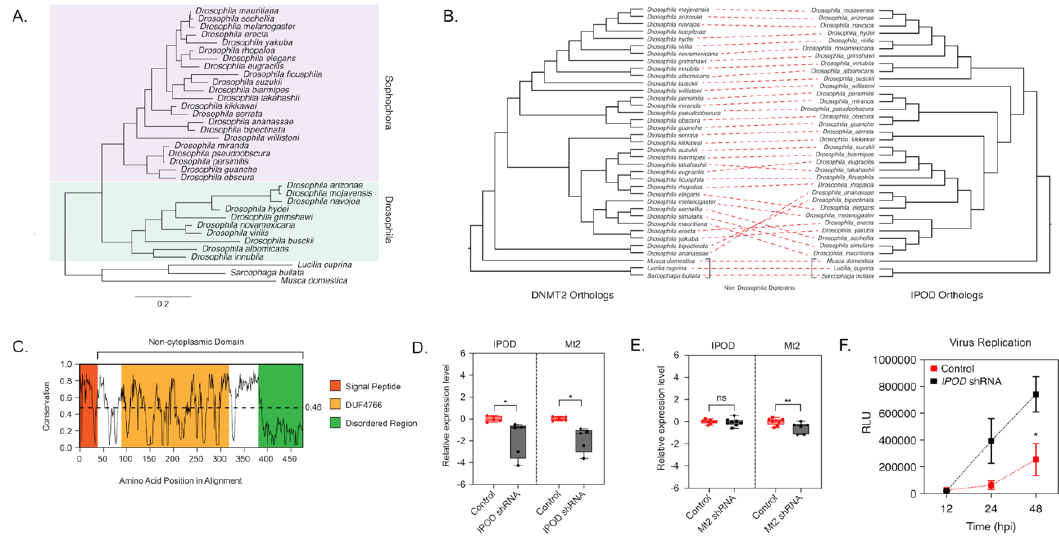
Figure 2. IPOD regulates DNMT2 expression in Drosophila. ( A ) maximum-likelihood [43] tree of the interaction partner of DNMT2 ( IPOD ) gene present in multiple Drosophila species was constructed using RAxML using a multiple sequence alignment of IPOD nucleotide sequences. The sequence of the IPOD orthologs from Lucilia cuprina, Musca domestica, and Sarcophaga bullata were used as outgroups. Scale bars represent branch lengths. ( B ) Inter-protein co-evolutionary analyses of DNMT2 and IPOD orthologs were performed using the TreeCmp software packages. Red dashed lines connect the same Drosophila taxon. ( C ) Shannon conservation plot representing the degree of conservation ( Y -axis) of IPOD orthologs present at every amino acid position ( X -axis) across Drosophilids . The horizontal dashed line indicates the mean conservation score (0.46) across all amino acid positions. Colored boxes represent three InterPro domains identified across all IPOD orthologs in Drosophilids , including the N-terminal signal peptide (depicted in orange), followed by a C-terminal non-cytoplasmic domain (depicted in white) consisting of a conserved domain of unknown function (DUF4766, depicted in yellow) and a glycine-rich disordered region (depicted in green) present at the C-terminal end. ( D , E ) IPOD is an upstream regulator of Mt2 expression in Drosophila melanogaster . ( D ) IPOD expression was knocked down in Wolbachia w Mel-colonized Drosophila melanogaster (TRiP line# 60092) by driving expression of a targeting short-hairpin RNA (shRNA) against the target IPOD mRNA. Relative expression of the target IPOD mRNA and Mt2 mRNA was assessed via quantitative RT-PCR using total RNA derived from age-matched females. Siblings lacking the shRNA were used as the negative control. Two-tailed t -tests on log-transformed values; IPOD : p < 0.05, t = 3.678, df = 8.00, Mt2 : p < 0.05, t = 2.454, df = 8.00. Error bars represent the standard error of the mean (SEM) of experimental replicates ( n = 5). ( E ) Mt2 expression was knocked down in Wolbachia w Mel-colonized Drosophila melanogaster by driving expression of a targeting short-hairpin RNA (shRNA) against the target mRNA. Relative expression of the target Mt2 mRNA and IPOD mRNA was assessed via quantitative RT-PCR using total RNA derived from age-matched females. Siblings lacking the shRNA were used as the negative control. Two-tailed t -tests on log-transformed values; Mt2 : p < 0.01, t = 2.576, df = 12.00, IPOD : p = 0.717969, t = 0.3686, df = 14.00. Error bars represent the standard error of the mean (SEM) of experimental replicates ( n = 6–8). ( F ) Effect of IPOD knockdown on Wolbachia- mediated virus inhibition. Age-matched Wolbachia- colonized female flies, either wild type or expressing IPOD -targeting shRNA, were intrathoracically injected with the SINV-nLuc virus. At indicated times post-infection ( X -axis), flies were harvested and snap-frozen before homogenization. Homogenized lysates were used to measure luciferase expression (RLU, Y -axis), which was subsequently used as a proxy to quantify virus replication. Two-way ANOVA of multivariate comparisons with Sidak’s post hoc test; IPOD knockdown: p < 0.01, Time: p < 0.01. Error bars represent the standard error of the mean (SEM) of experimental replicates ( n = 3/time point). * p < 0.05, ** p < 0.01, ns =